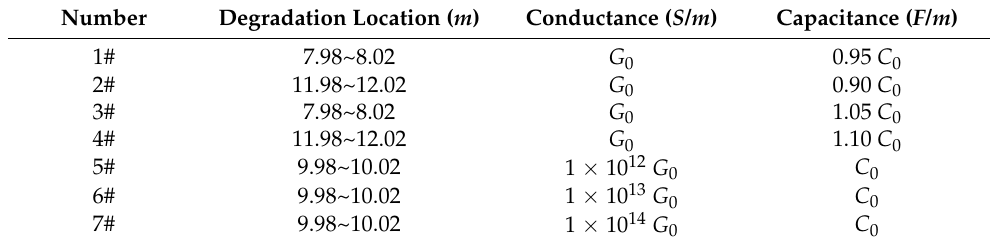
Table 2. The characteristics of 1#–7# simulated cable.